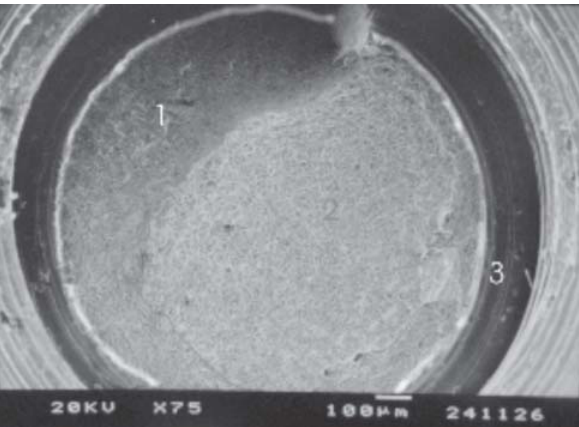
FIGURE 5- Zones of fracture development by fatigue in the screw center F(-) 75x. 1) crack nucleation; 2) crack propagation; 3) test specimen